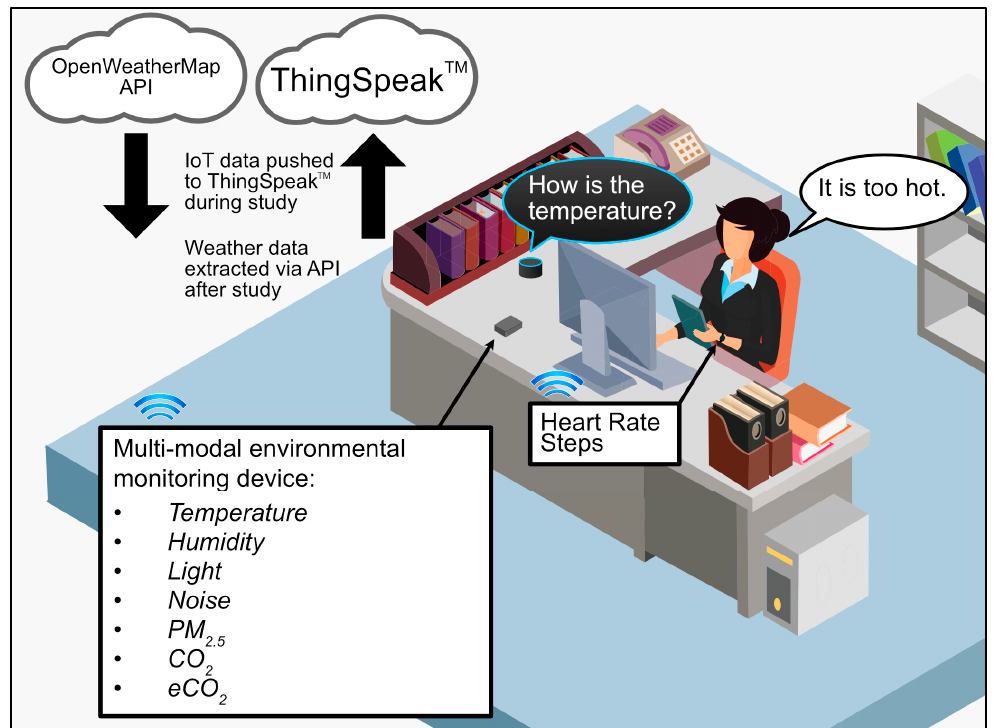
Figure 1. Diagram showing the general monitoring environment of the study including passive en- vironmental sensors, wearables, voice-assisted surveys, and cloud platforms.